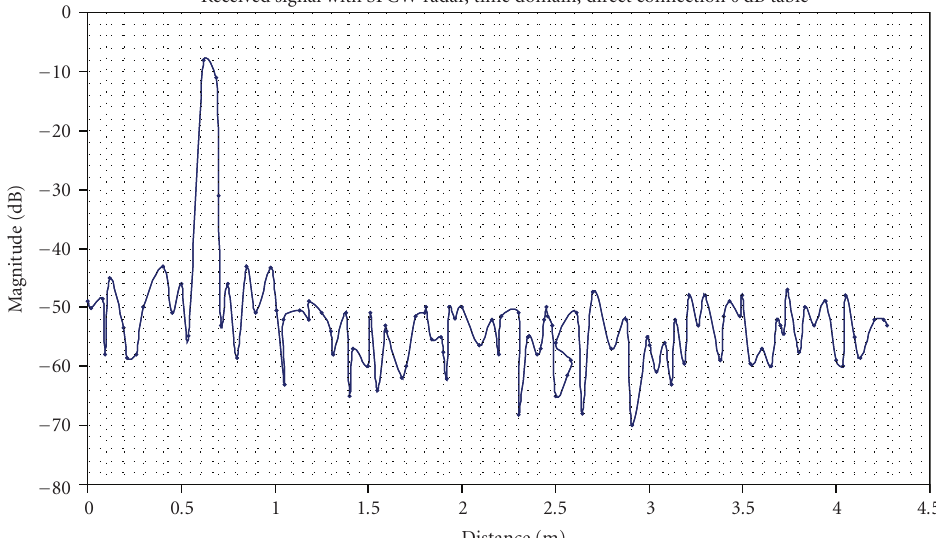
Figure 11: A scan (range profile) after removing the DC o ff set and the delays within the transmitter and the receiver.